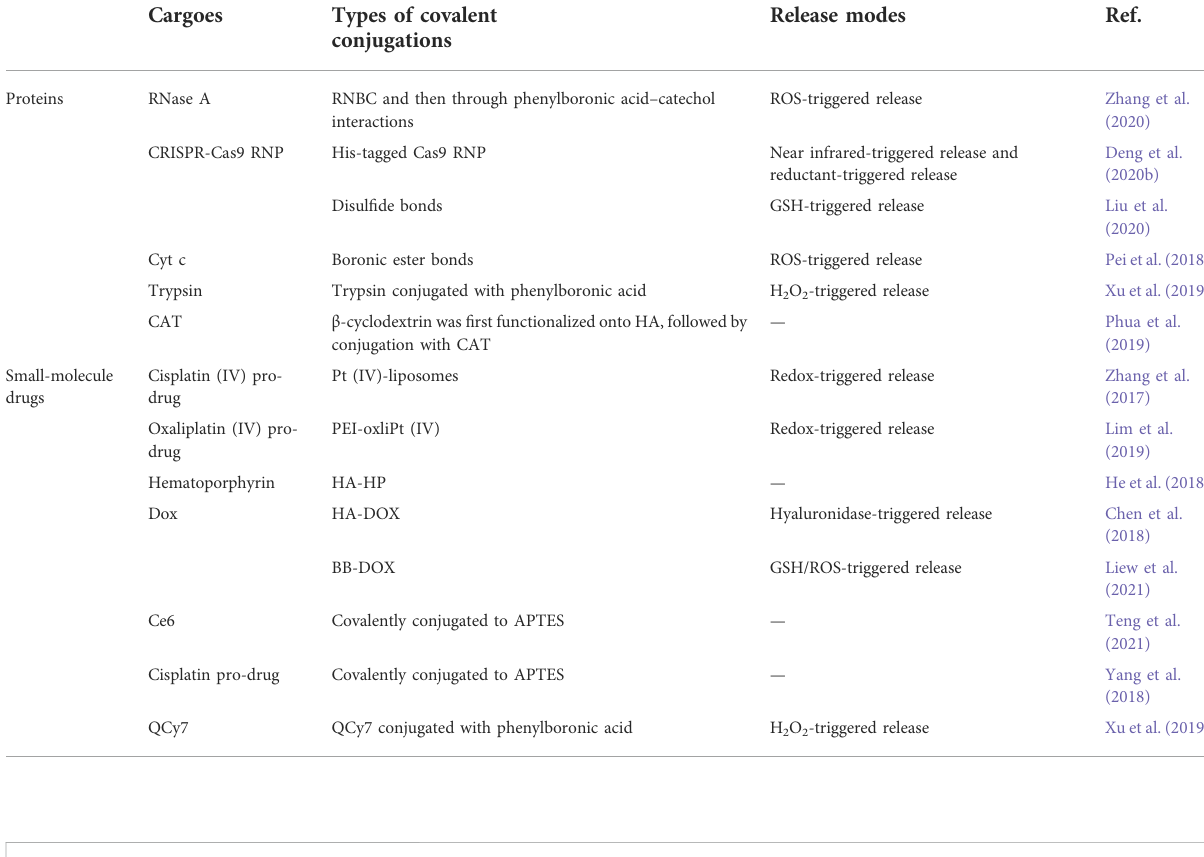
TABLE 2 Summary of covalent bonds applied for the loading of proteins or small-molecule drugs into intracellular co-delivery systems.